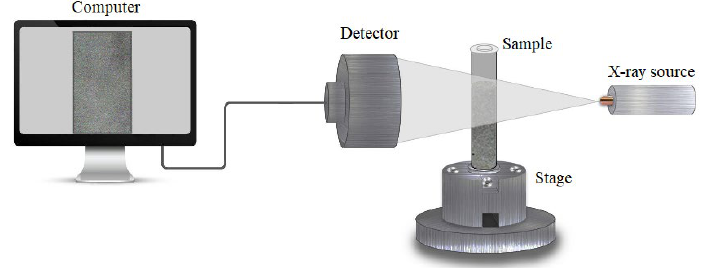
Figure 4. Schematic view of the mechanism of imaging in the TXM method.